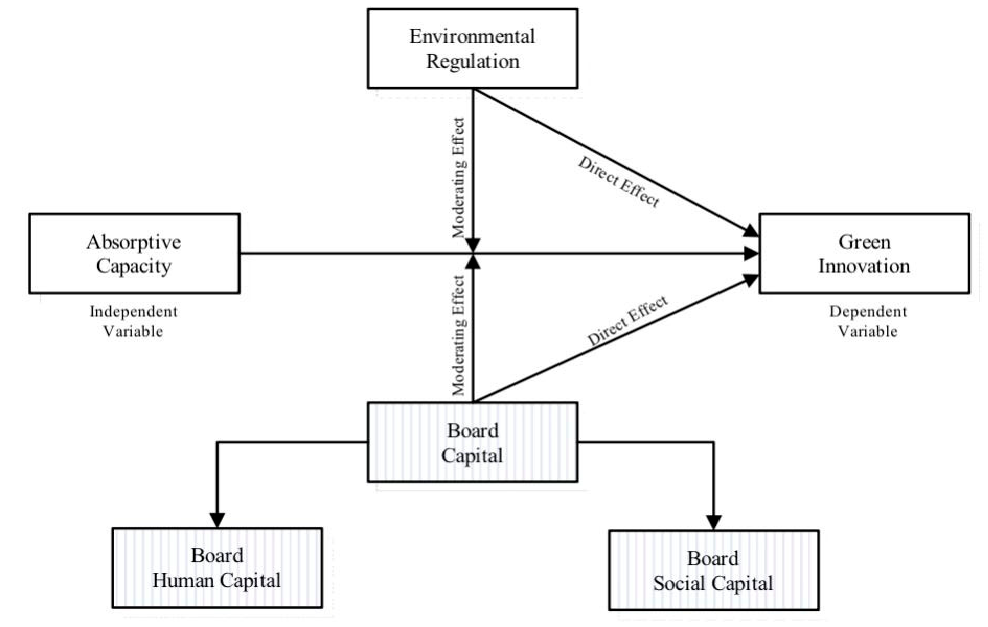
Figure 1. Theoretical Model.